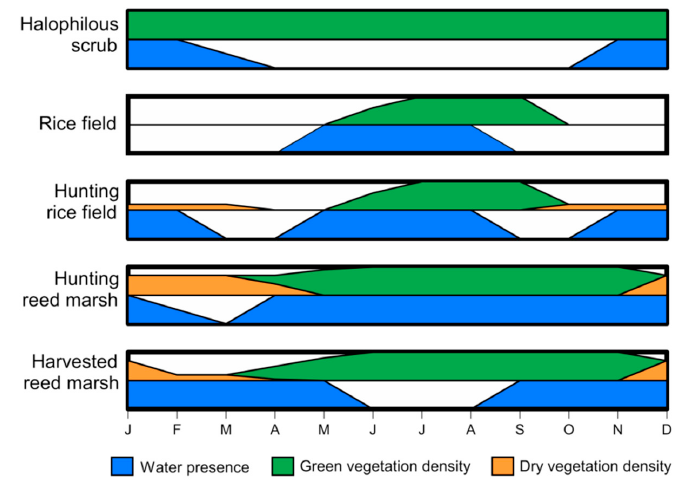
Figure 2. Monthly hydroperiod and vegetation development for different wetland types in relation to human uses in Camargue.